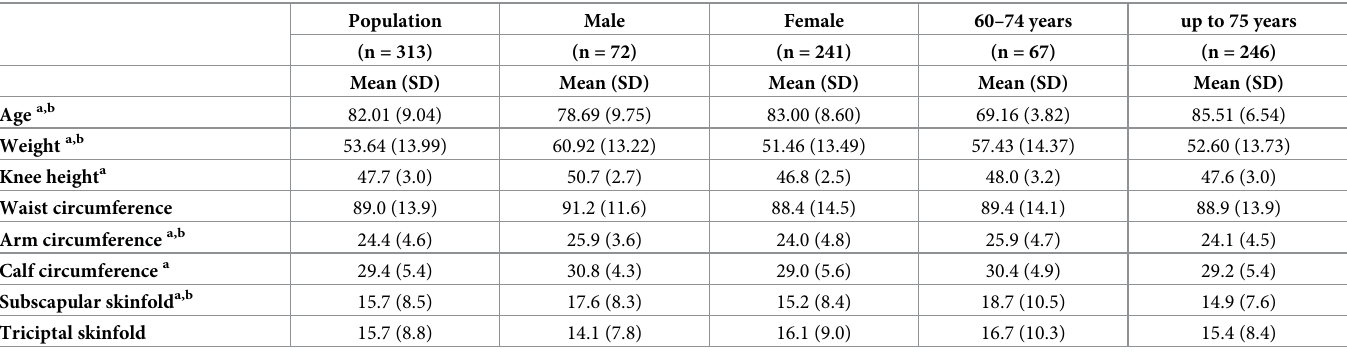
Table 1. Physical and biological characteristics of older adults by sex and age group.